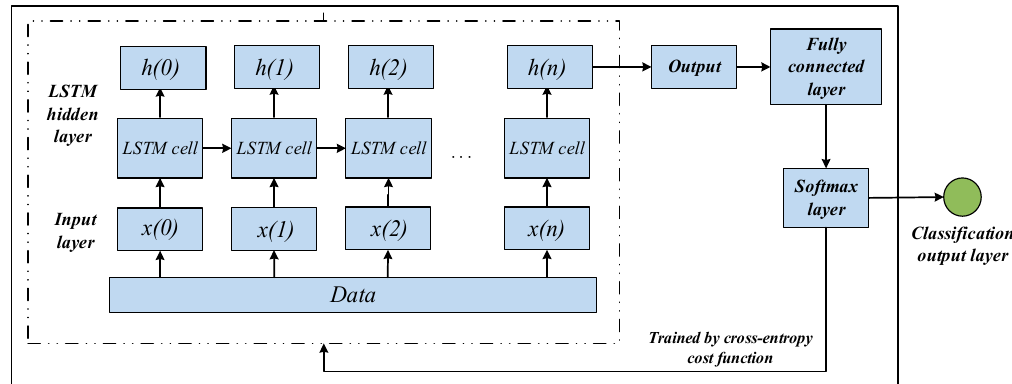
Figure 2. The architecture for LSTM network.